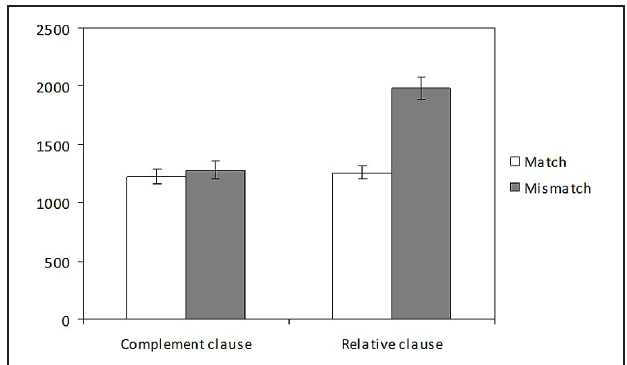
FIGURE 3 | Distribution of RTs (ms) for correct judgments at the target verb in the speeded grammaticality judgment task of Experiment 2.